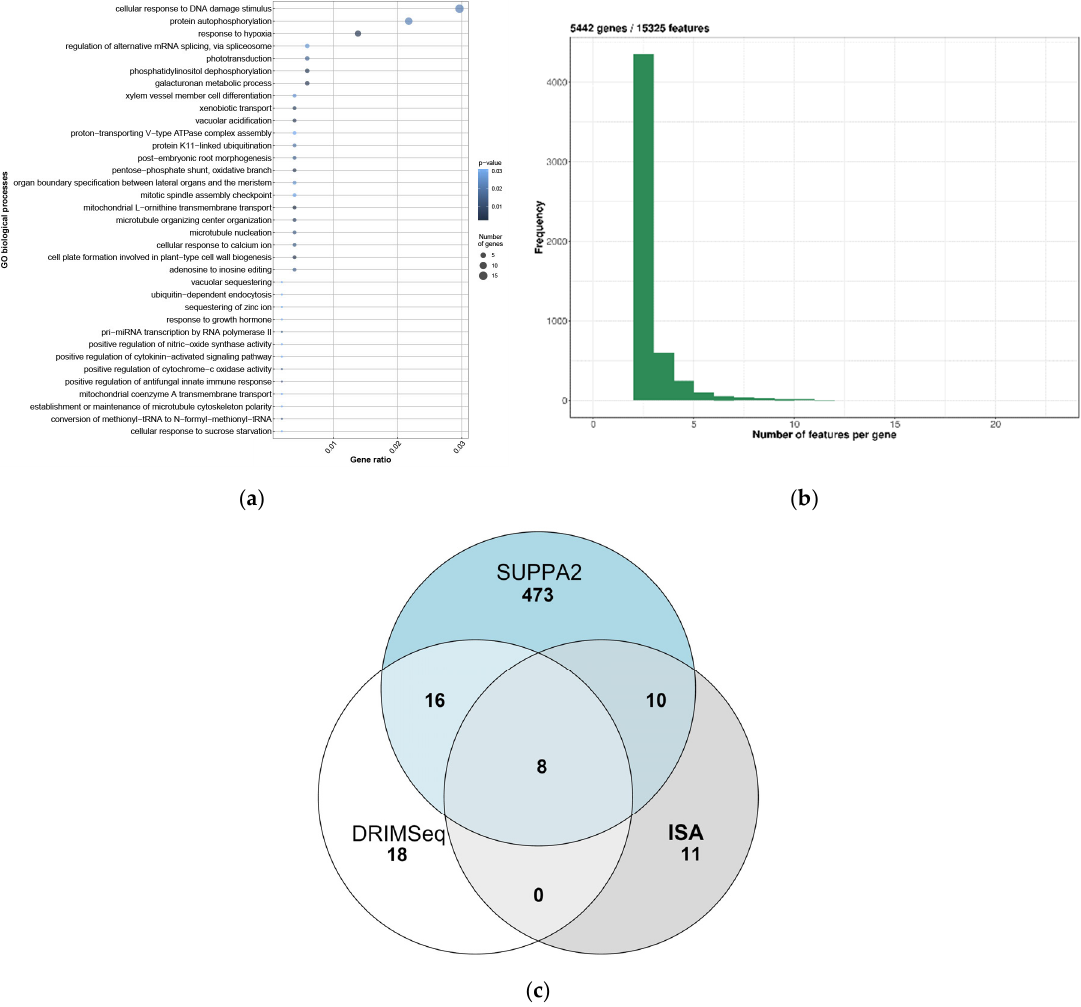
Figure 3. ( a ) Functional groups of genes demonstrating differential AS in mycorrhizal roots of